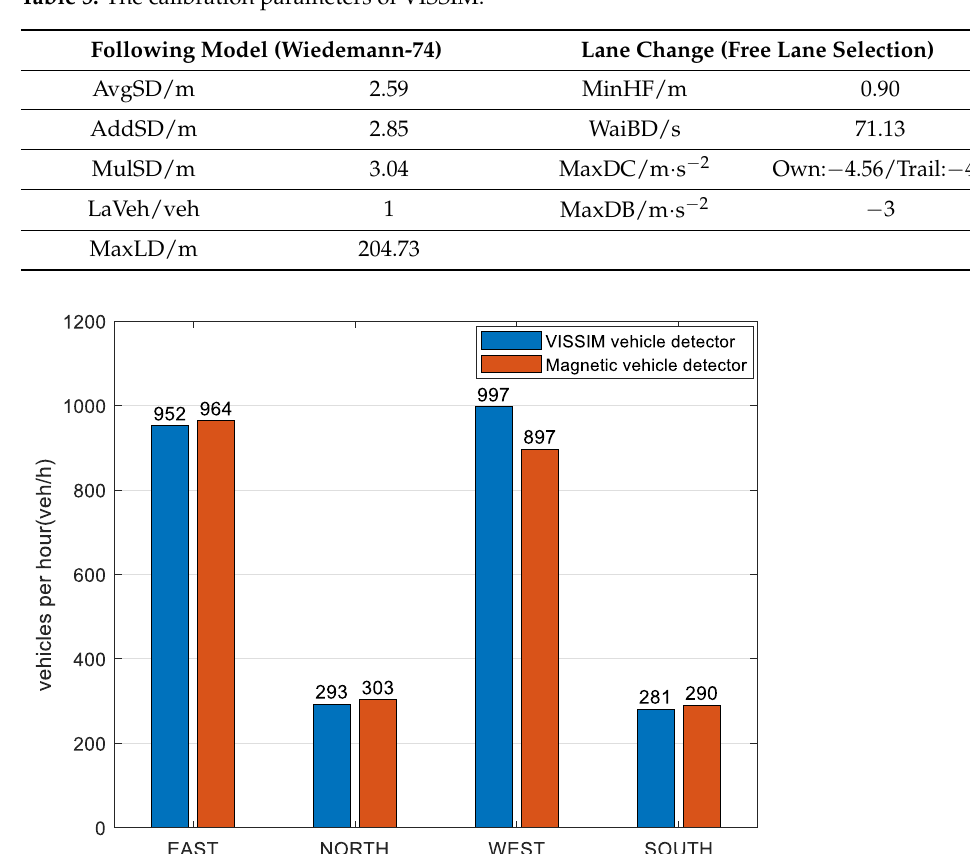
Table 5. The calibration parameters of VISSIM.